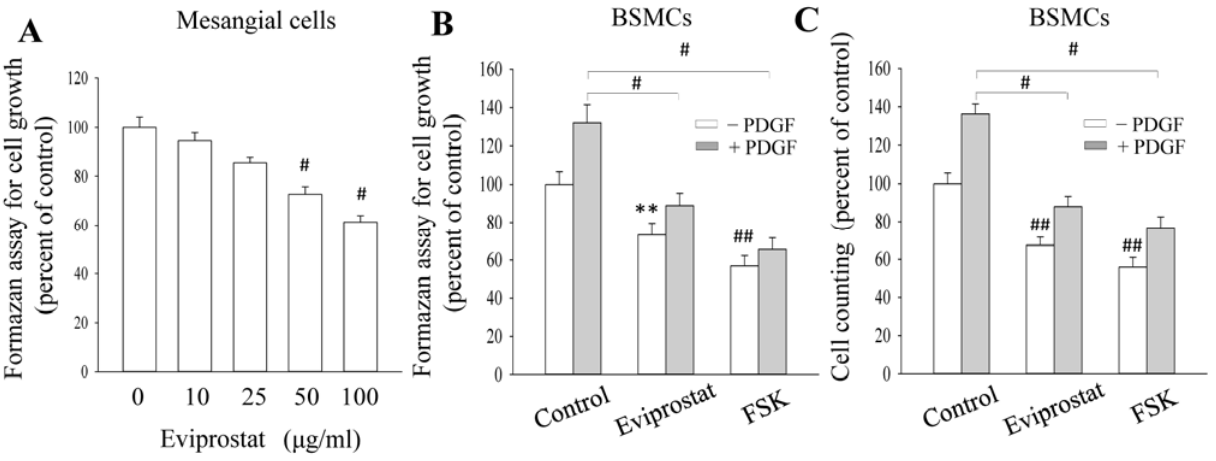
Figure 4. Anti-proliferative effect of Eviprostat. ( A ) Dose-dependent effects of Eviprostat on mesangial cell proliferation. Mesangial cells were pretreated with the indicated concentrations of Eviprostat for 1 h before exposing to 20 ng/mL platelet-derived growth factor (PDGF) for 24 h. Cell growth was evaluated by formazan assay. The data were expressed as percent of the control at zero point (mean ± SE, n = 4), # p < 0.01 vs. zero point control. ( B and C ) Effects of Eviprostat and forskolin (FSK) on bladder smooth muscle cells (BSMCs) proliferation. BSMCs were treated with 50 μ g/mL Eviprostat or 10 μ M FSK for 1 h before incubation with 20 ng/mL PDGF for an additional 24 h. Cell growth was determined by either formazan assay ( B ) or direct cell counting ( C ). The data were expressed as percent of untreated control (mean ± SE, n = 4); # p < 0.01 vs. PDGF alone, ** p < 0.05 and ## p < 0.01 vs. untreated control. ( D and E ) Effect of Eviprostat on hillock formation. BSMCs were pretreated with 50 μ g/mL Eviprostat for 12 h or left untreated and exposed for 20 ng/mL PDGF for additional 48 h. The cell morphology was photographed ( C , magnification: 200×), and the number of hillocks was manually counted in a blind manner and were shown in D. Results were expressed as the average number of hillocks counted in ten fields. # p < 0.01 vs. PDGF alone. Arrows denote multilayered ridges and nodules, the characterized feature of